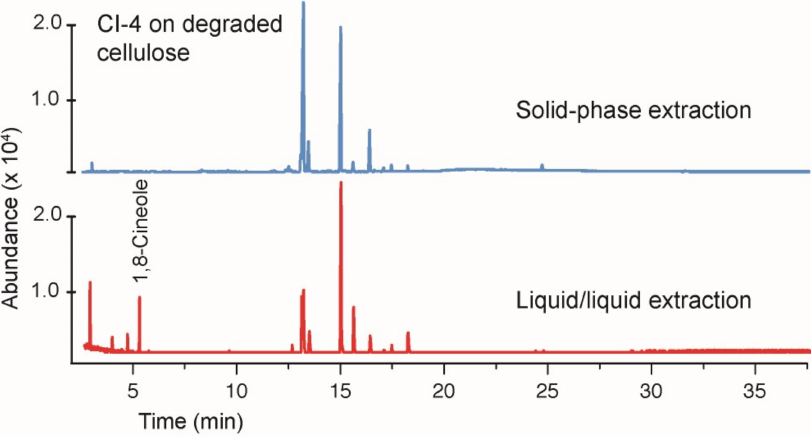
Figure 6. A comparison of the solid-phase extraction versus the liquid–liquid extraction (ethyl acetate/water). The growth media contained the degraded cellulose as a carbon source. A notable difference is the presence of 1,8-cineole in the liquid–liquid extraction. A comparison of the potato dextrose broth gave very similar results and, therefore, is not shown. The identity of 1,8-cineole was verified by comparison to an authentic